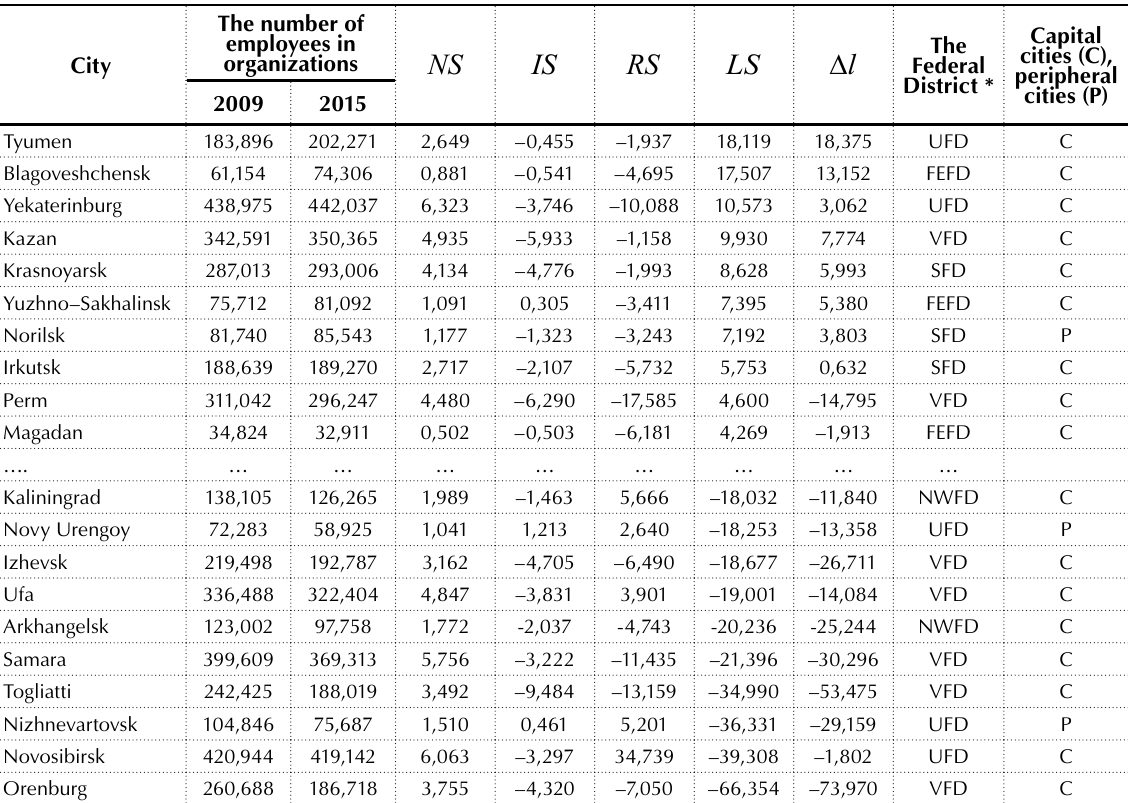
Source: calculated by the authors according to